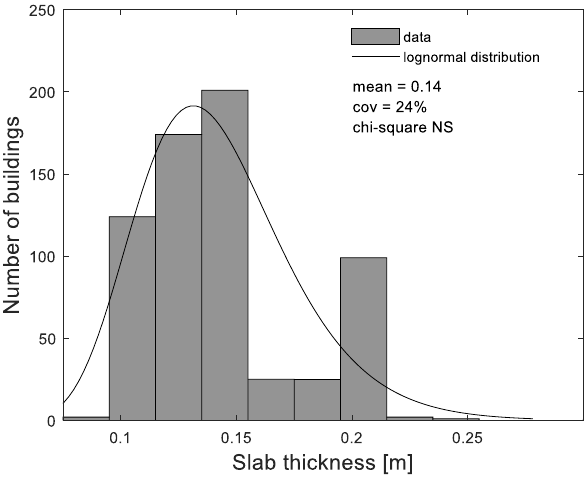
Figure 15. Distribution of slab thickness for all RC buildings. Table 6. Probabilistic distribution of slab thickness for the RC building stock of each